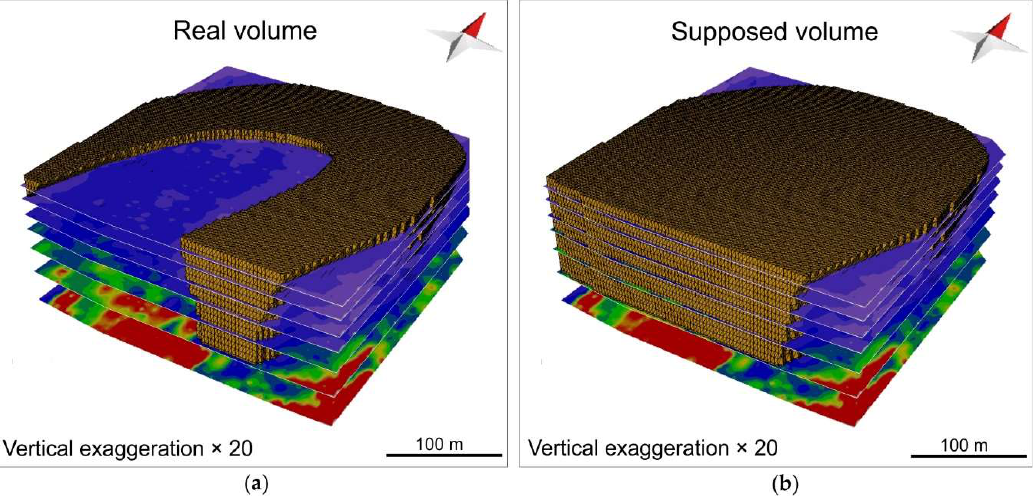
Figure 10. old9 . Volume of the point-bar body ( a ) reconstructed through the present study Figure 10. Volume of the point-bar body ( a ) reconstructed through the present study and ( b ) inferred and ( b ) inferred assuming bar growth from a straight channel, as suggested by classical assuming bar growth from a straight channel, as suggested by classical sedimentological models. sedimentological